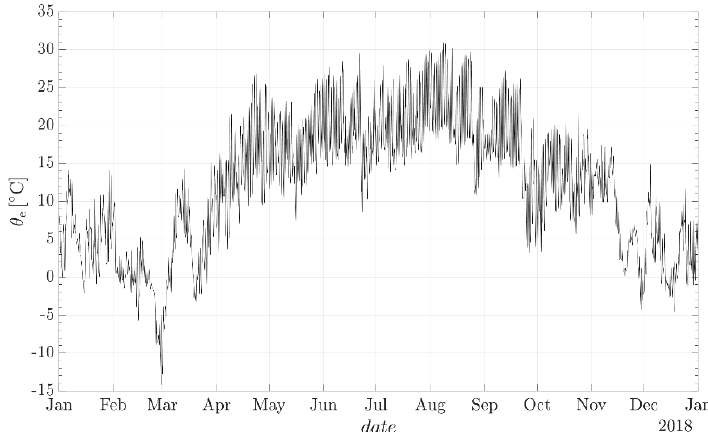
Figure 6. Temperature profile of the outer side of the building in the year 2018.